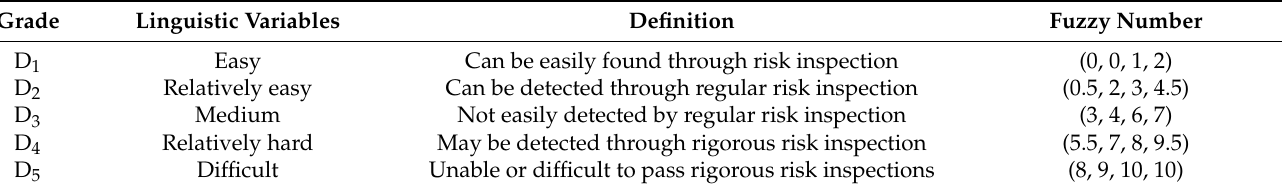
Table 4. Fuzzy rating of risk detection degree D.